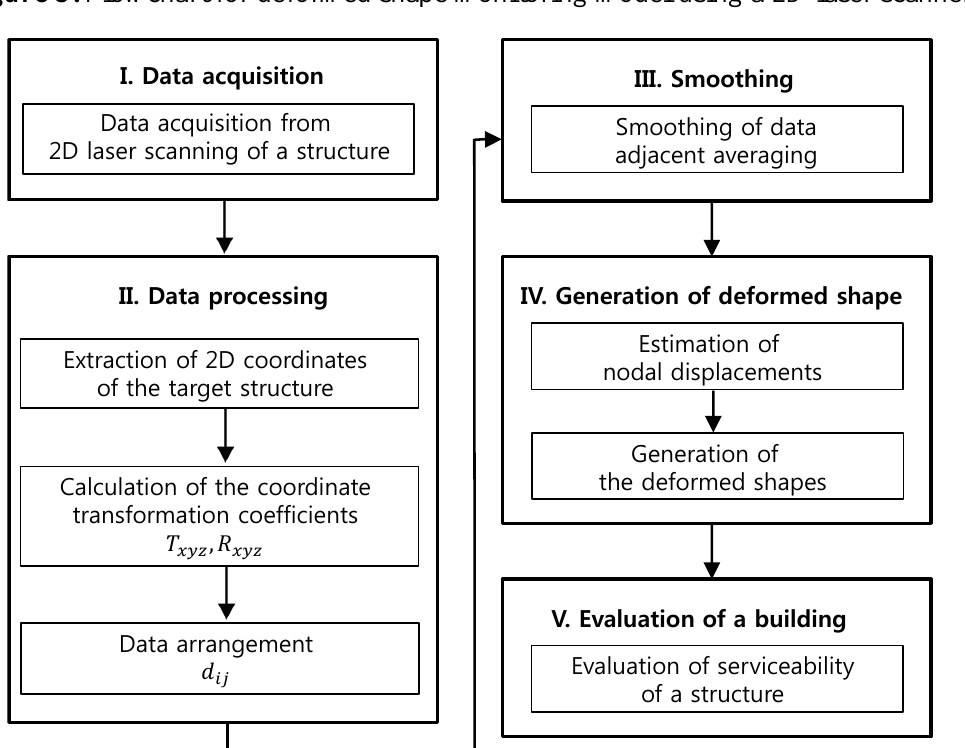
Figure 3. Flowchart for deformed shape monitoring model using a 2D laser